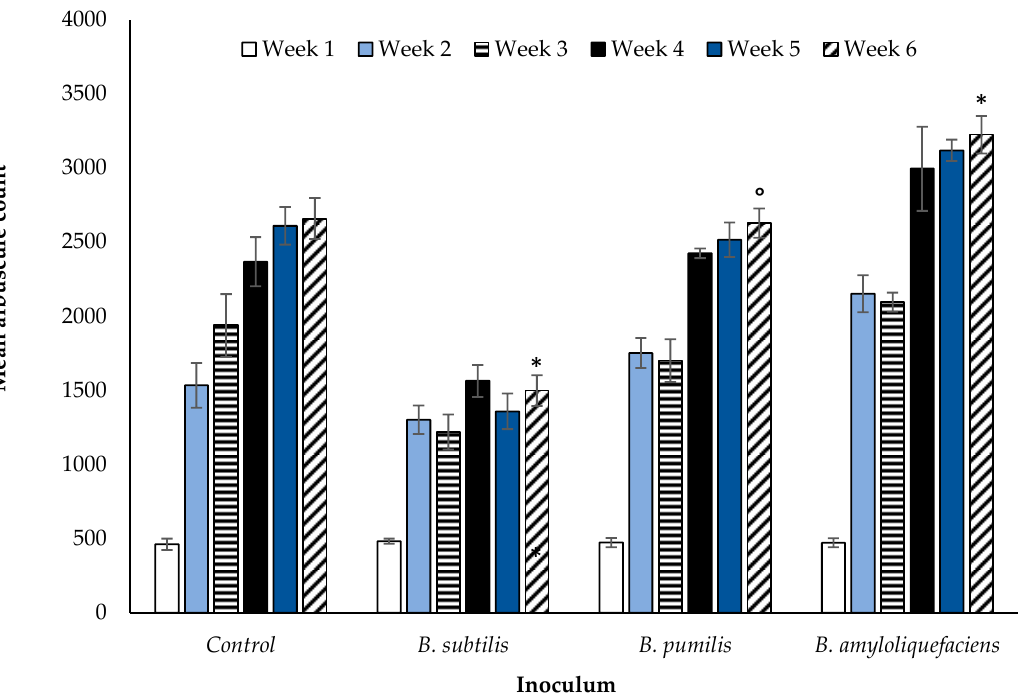
Figure 1. Average ( n = 270 overall) arbuscule count for inoculated winter wheat over a six week period. Significant ( p < 0.0001) for single factor ANOVA. TRUE Bonferroni corrections (*), FLASE Bonferroni corrections (°). Error bars = one standard error of the mean (SEM).